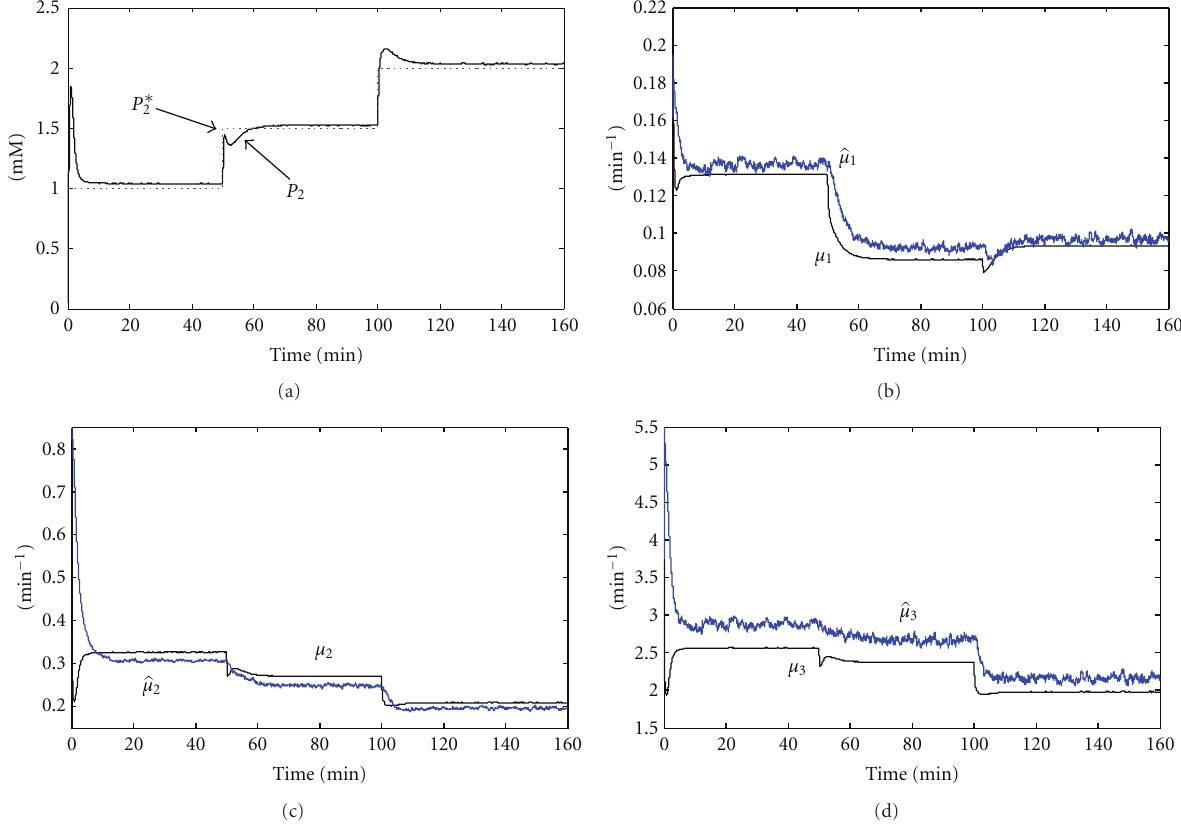
Figure 6: Simulation results—adaptive control law (noisy measurements). Panel (a) shows the profile of the output y = P 2 (ampicillin concentration) versus the reference y ∗ = P ∗ 2 , in the adaptive case, when noisy measurements of S 1 and S 2 are used in both estimation and control algorithms. Panels (b), (c), and (d) present the profiles of specific reaction rates μ 1 , μ 2 , and μ 3 together with their estimates (cid:18) μ 1 , (cid:18) μ 2 and (cid:18) μ 3 , respectively, in the case of noisy measurements.